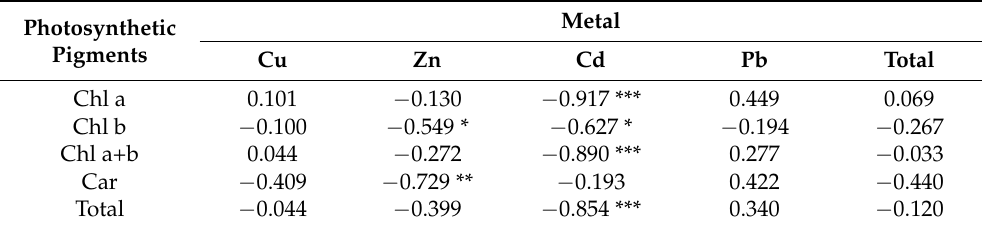
Table 3. Pearson correlations between photosynthetic pigments and metal concentration in leaves of S. perfoliatum